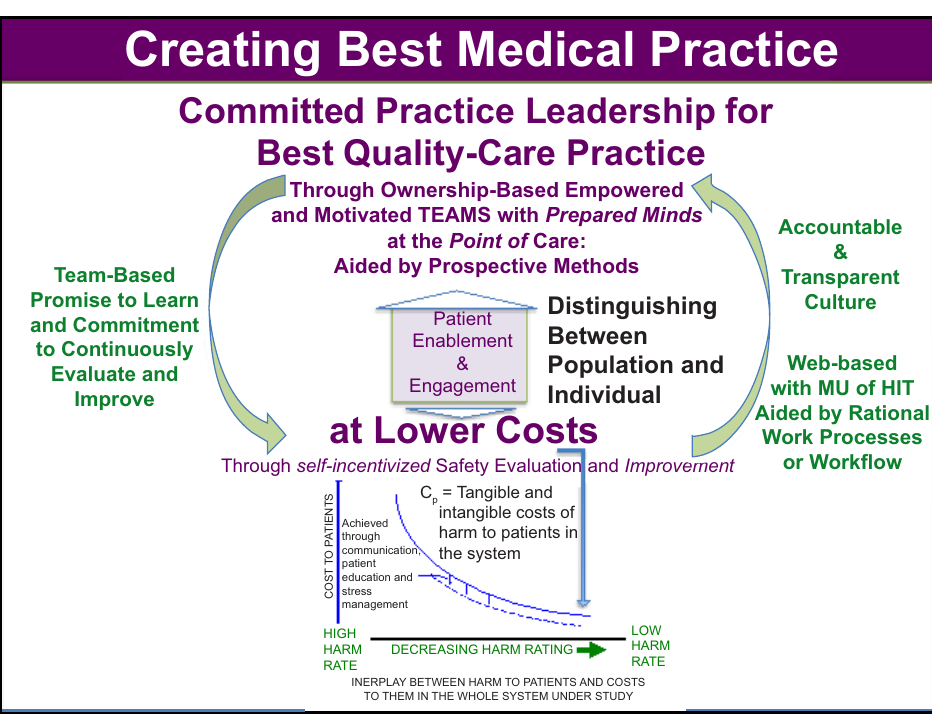
Figure 6. Concept For Minimum Harm Practice with its vital determinants.